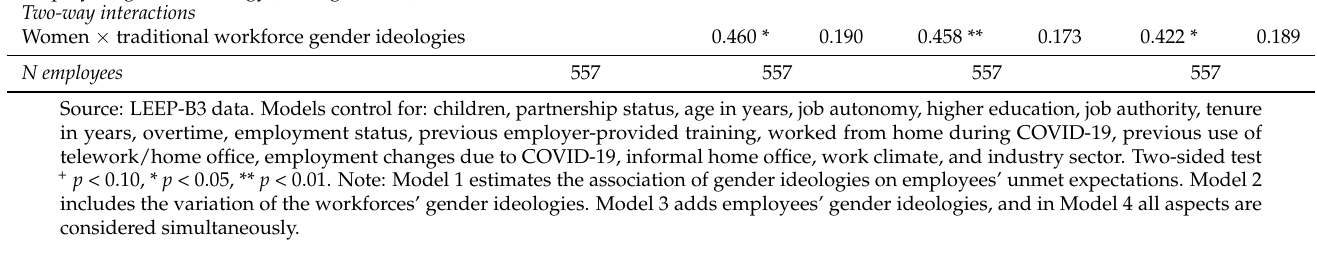
Table A3. Results of linear regression models estimating the association of gender with individual- level characteristics and workforce gender ideologies on employees’ unmet expectations controlling for the share of women within the workplace (Model 1) and the share of employees who used working from home arrangements pre-COVID-19 (Model